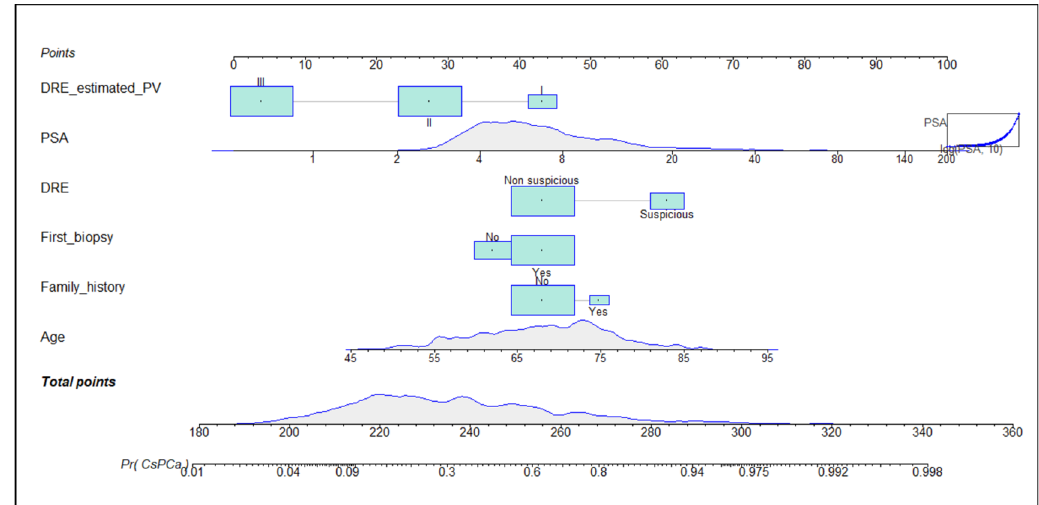
Figure 1. Nomogram of development model. DRE_estimated_PV = digital rectal examination prostate volume category; PSA = prostate ‐ specific antigen; Pr = probability.